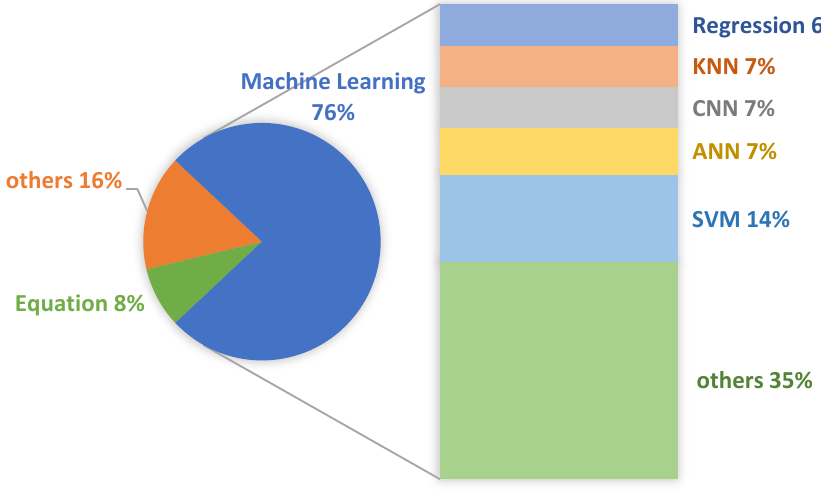
Figure 6. The proportion of algorithms used.